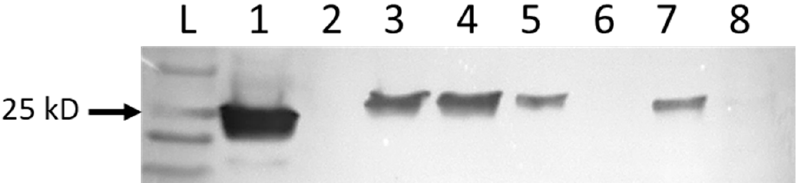
Figure 2. Western blot of denatured proteins extracted from noninfected control V76 cells (lane 6), or infected with the MP-12 vaccine strain of Rift Valley fever virus (lane 1), RGV (lanes 3–5), An- hanga virus (lane 7), or Punta Toro virus (lane 8). Lane 2 was left open to ensure no spillover from the positive MP-12-infected cells. Protein bands were identified with the primary antibody rabbit anti-RVFV nucleocapsid protein, and the secondary antibody mouse anti-rabbit-IgG-HRP. The ar- row indicates the 25 kD band of the protein ladder. Proteins of the expected size were identified for MP-